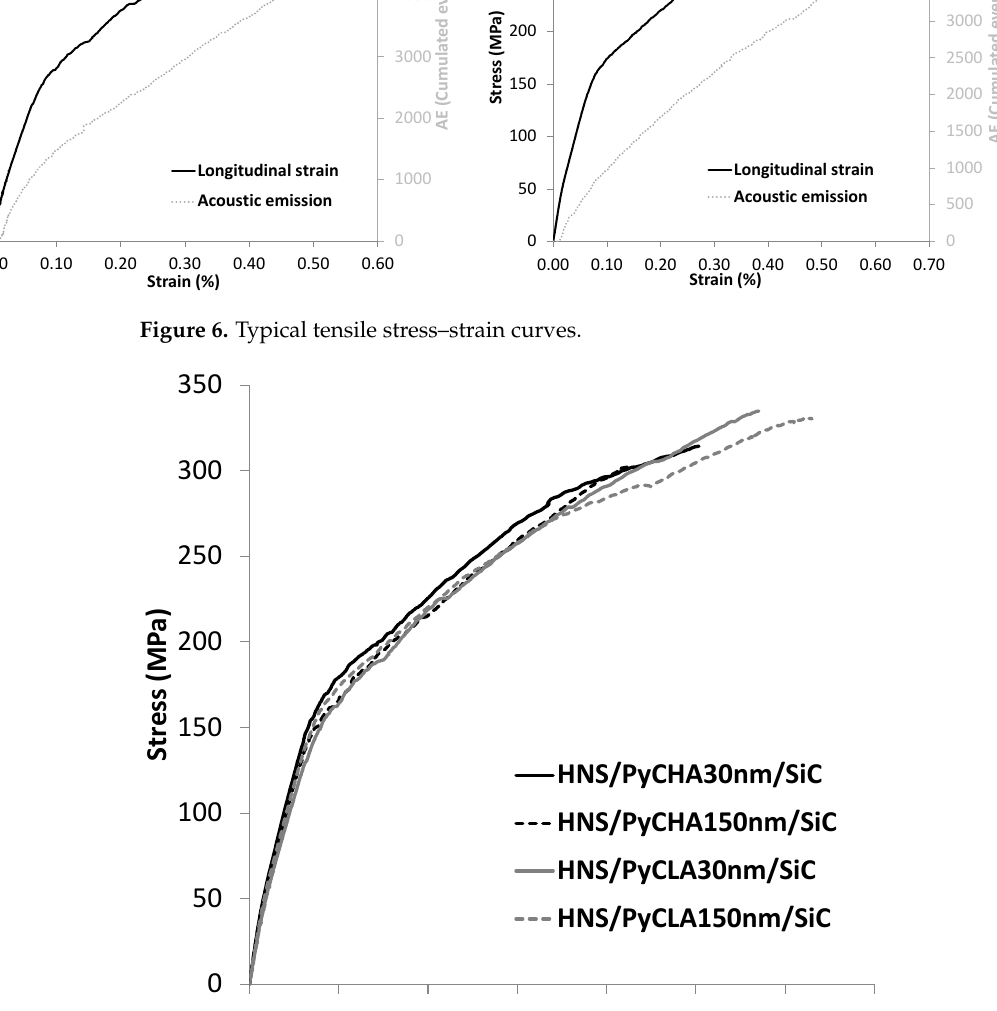
Figure 7. Influence of PyC texture and thickness on the tensile stress–strain behavior.